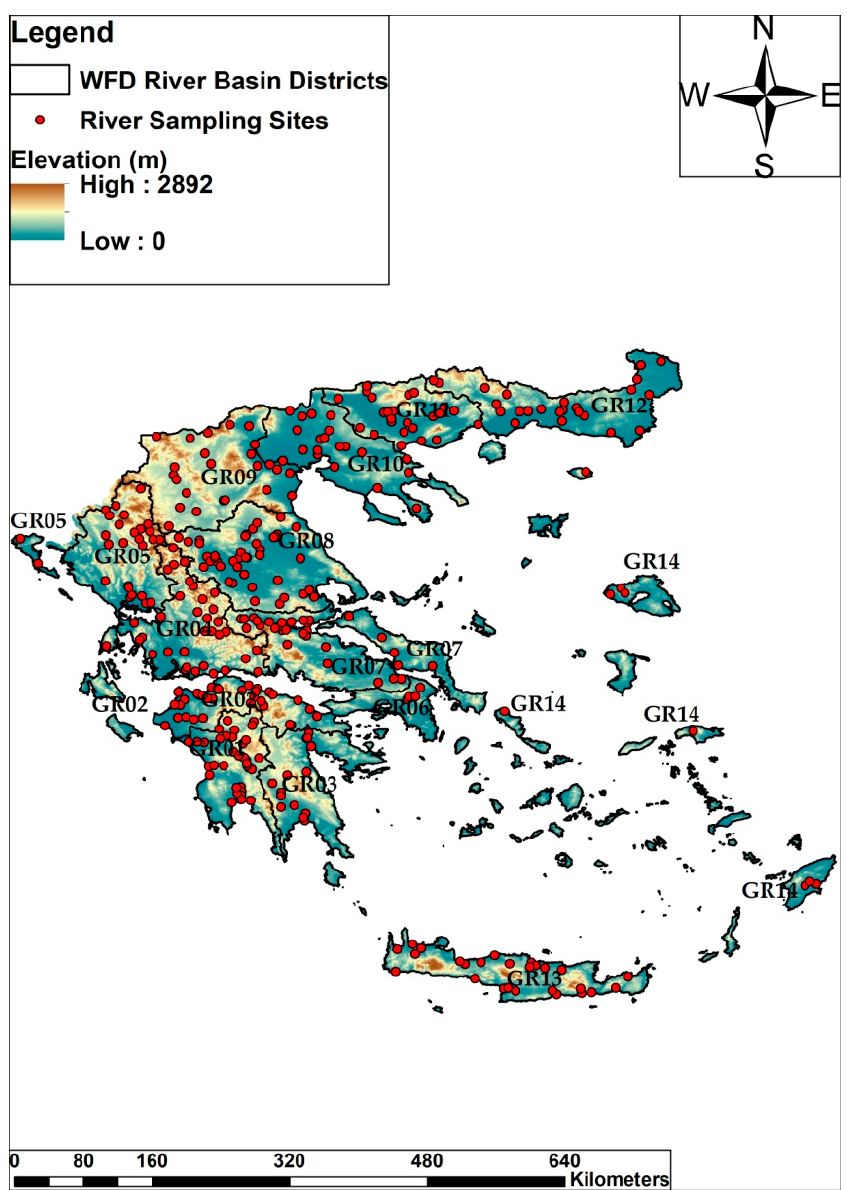
Figure 1. Location of the river sampling sites.